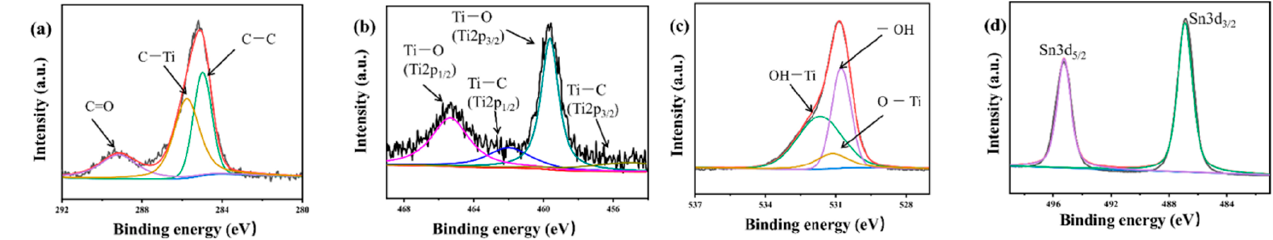
Figure 21. The high-resolution XPS spectra of ( a ) C 1s; ( b ) Ti 2p; ( c ) O 1s; ( d ) Sn 3d, respectively